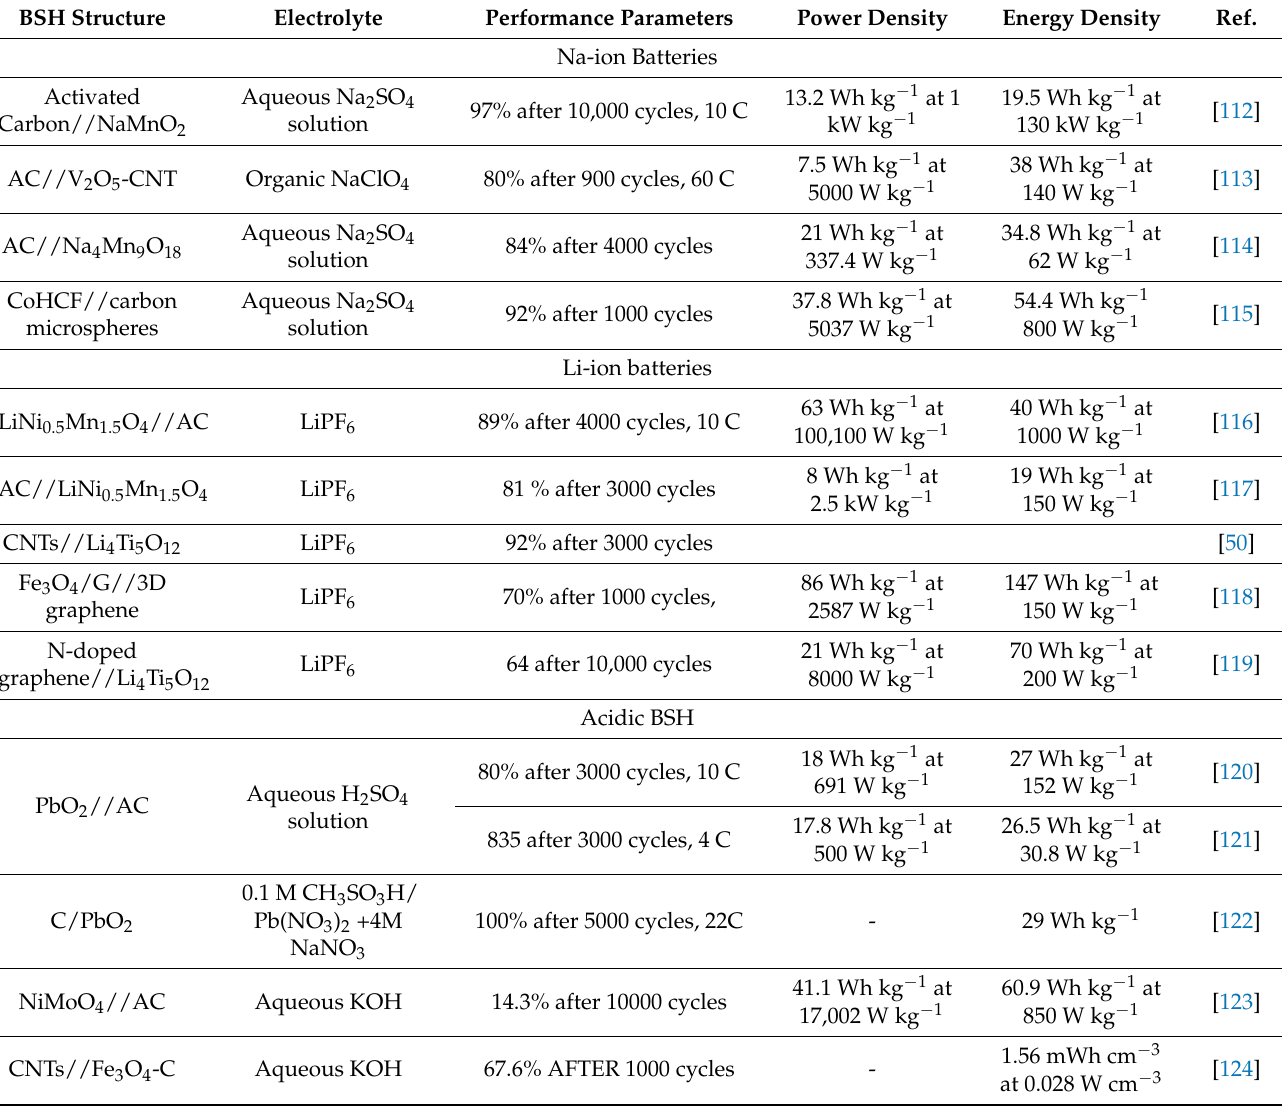
Table 3. Battery-supercapacitor hybrid (BSH) systems with their performance